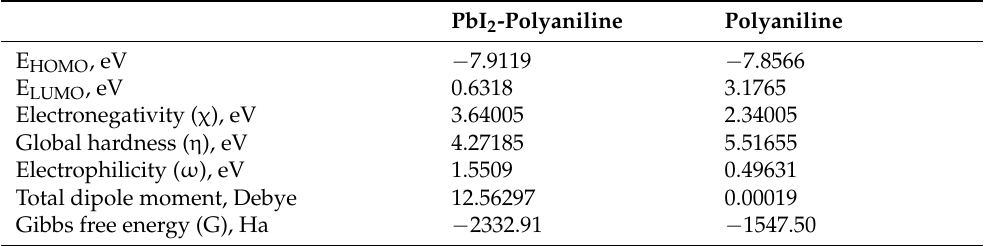
Figure 8. Optimized geometry of the PANI/PbI 2 composite. The binding energy between PbI 2 and the polyaniline. Table 4. Some of the calculated electrochemical and thermal properties of the optimized PI 2 -Poly